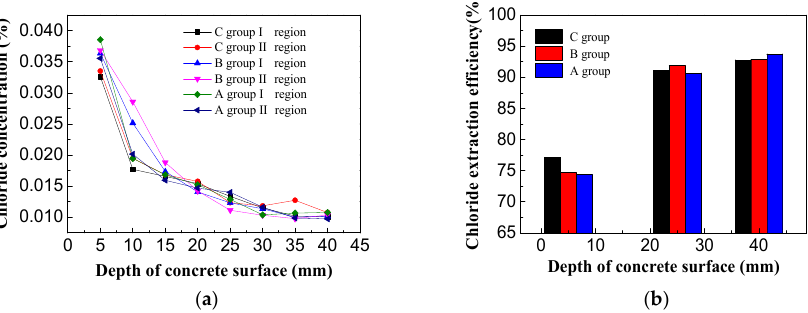
Figure 12. ( a ) Chloride concentration of concrete specimens; ( b ) Chloride extraction efficiency of concrete specimens.